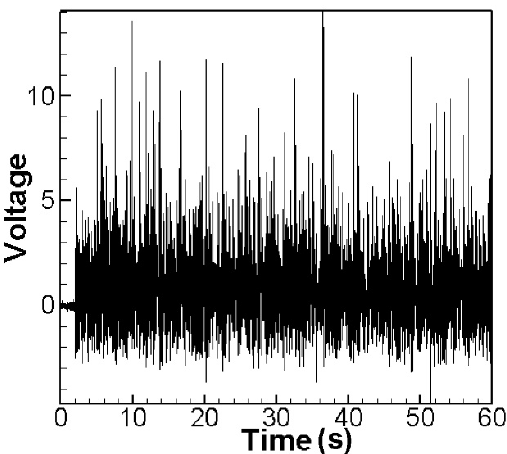
Figure 13. Experimental voltage output for nonlinear frequency excitation (elastic steel 10 cm), 1st mode.